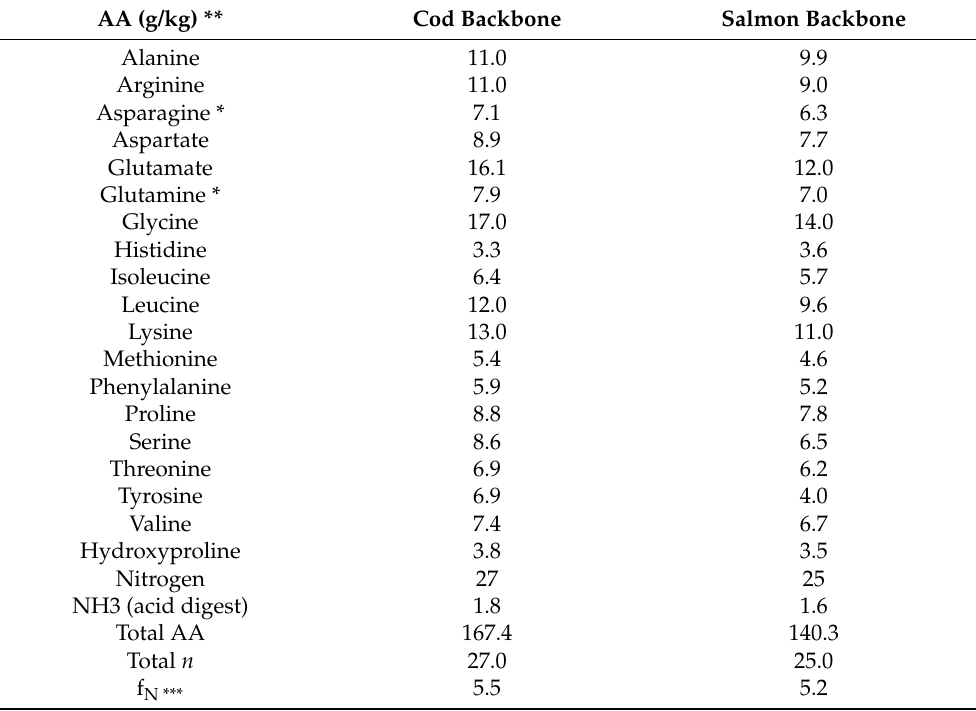
Table 1. Amino acid composition in the raw material (g kg − 1 ; n = 2) and substrate specific nitrogen- to-protein conversion factor data of salmon ( Salmo salar ) and Cod ( Gadus morhua ) backbones. AA (g/kg) ** Cod Backbone Salmon Backbone Alanine 11.0 9.9